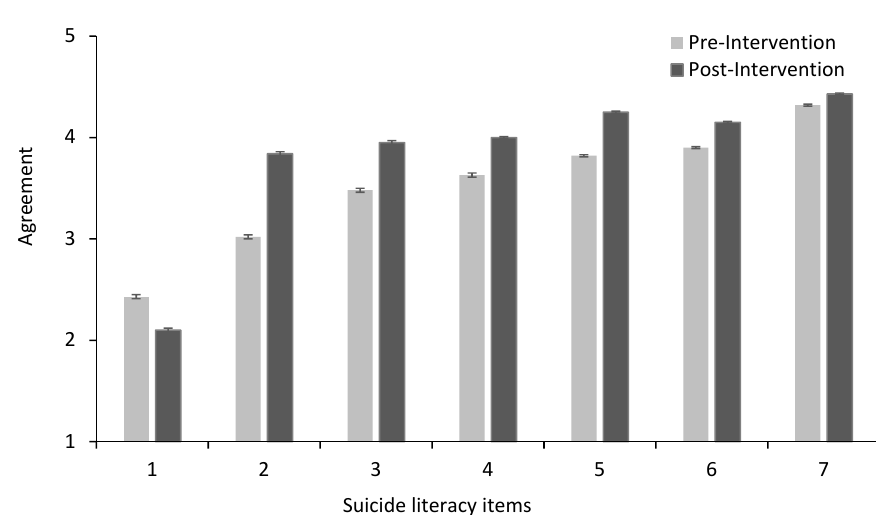
Figure 1. Estimated marginal means for suicide literacy pre- and post-intervention. Note. Error bars represent standard errors. On the x -axis, 1 = “Asking a workmate if they are having suicidal thoughts can increase his / her risk of suicide”, 2 = “People considering suicide often send out warning signs